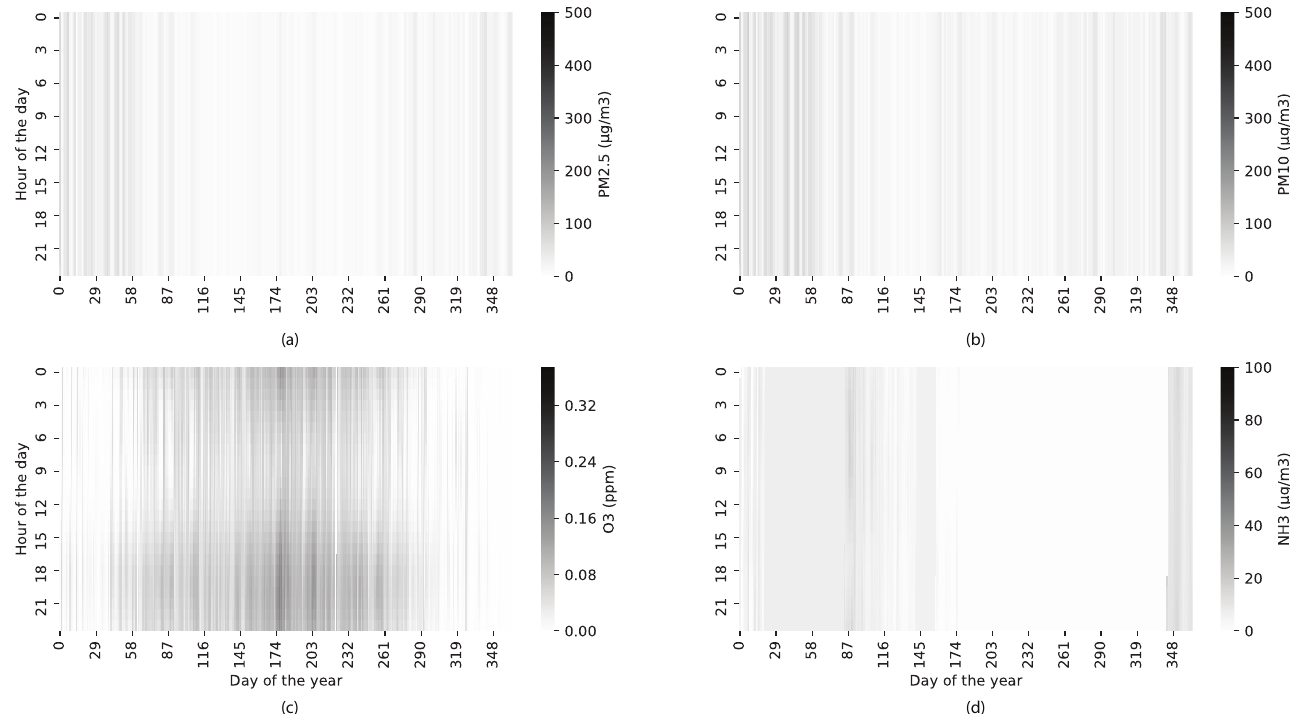
Figure 4. Degree of air pollution concentration in the AQI , based only on the 2019 values from Milano v. Juvara for ( a ) PM 2.5 , ( b ) PM 10 , ( c ) O 3 , and ( d ) NH 3